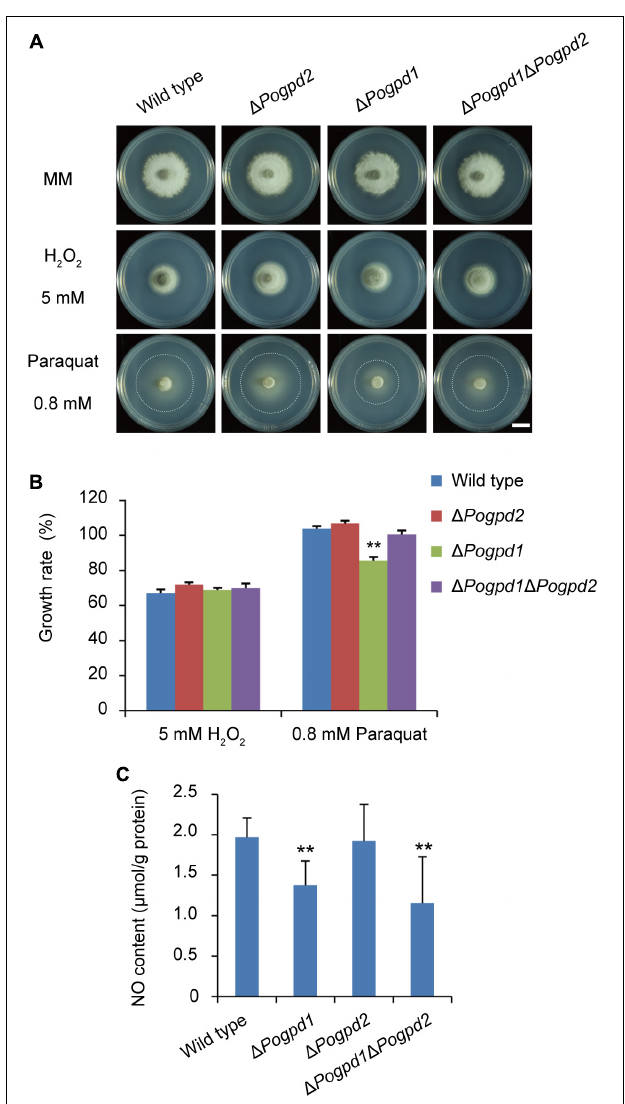
FIGURE 8 | Roles of glycerol-3-phosphate dehydrogenases in response to ROS stress. (A) Colonies of the wild type, (cid:49) Pogpd1 , (cid:49) Pogpd1 (cid:49) Pogpd2 , and (cid:49) Pogpd2 cultured on MM media with 5 mM H 2 O 2 or 0.8 mM paraquat for 8 days. Bar = 5 mm. (B) Relative growth rate of substrate mycelia in Pyricularia oryzae strains on media with 5 mM H 2 O 2 or 0.8 mM paraquat. Pogpd1c is a complementation strain of (cid:49) Pogpd1 . (C) The NO content of aerial hyphal cells in the wild type, (cid:49) Pogpd1 , (cid:49) Pogpd2 , and (cid:49) Pogpd1 (cid:49) Pogpd2 cultured on CM medium. Error bars represent SD. Significant difference compared